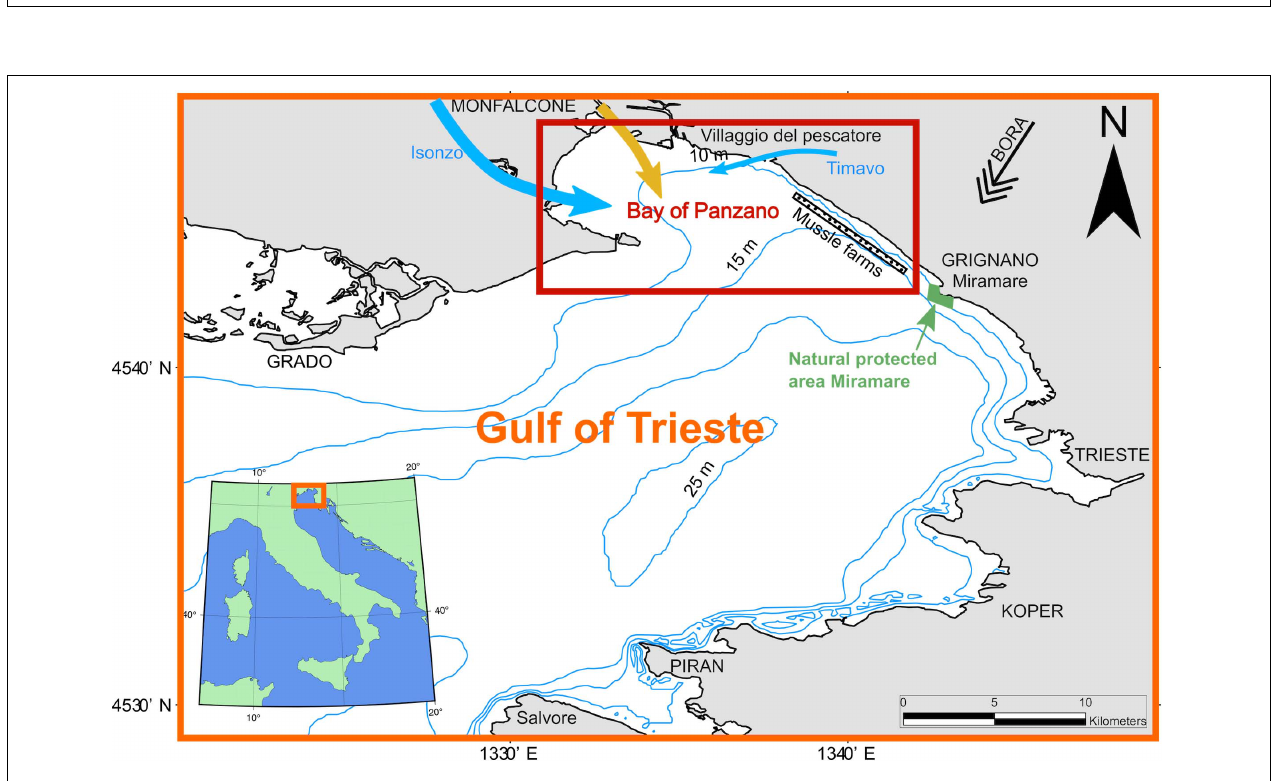
FIGURE 11 | The Gulf of Trieste (Northern Adriatic Sea) and the study area: the bay of Panzano.